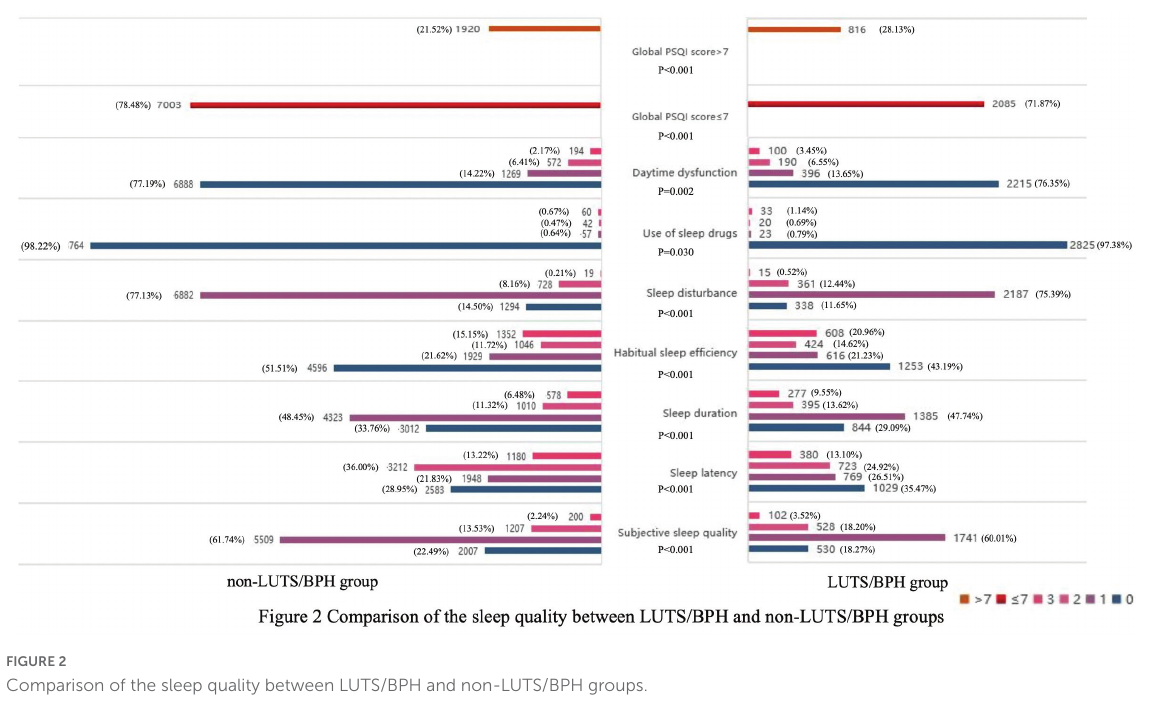
FIGURE2 Comparison of the sleep quality between LUTS/BPH and non-LUTS/BPH groups.